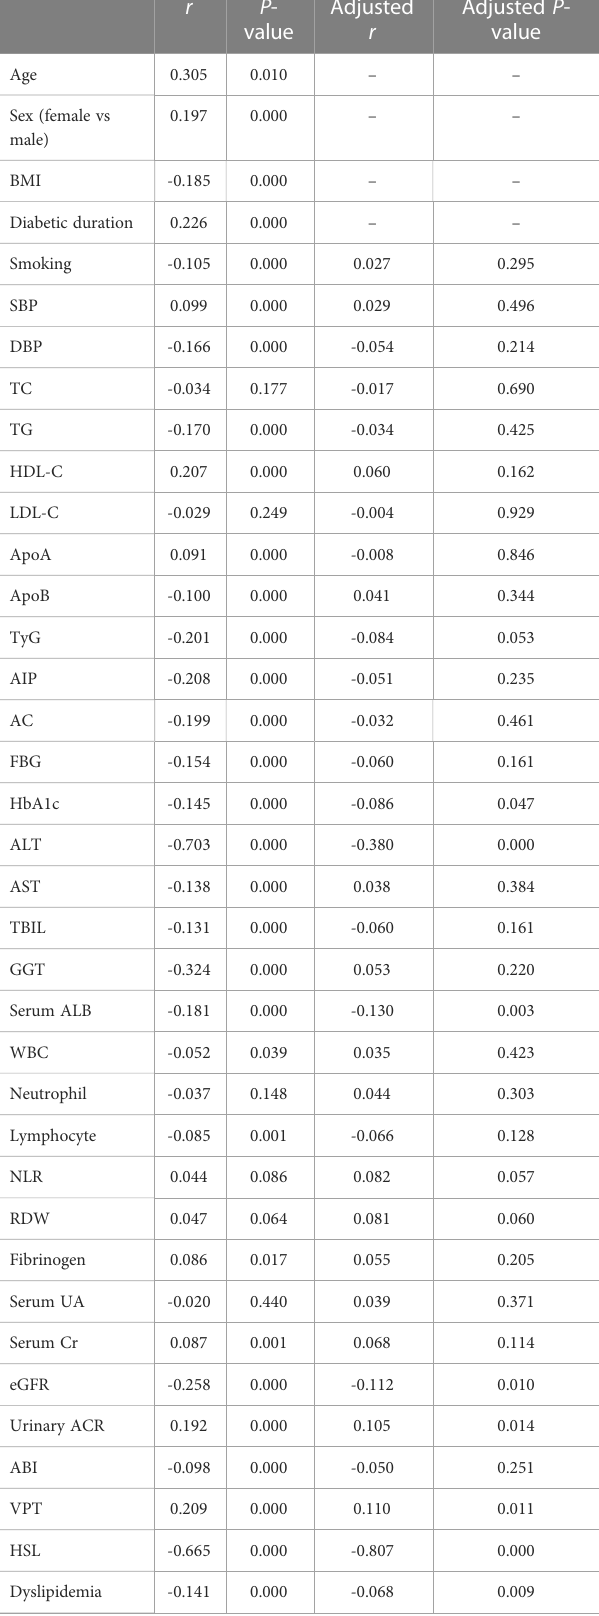
TABLE 2 Association between AAR and clinical and laboratory characteristics in study subjects.